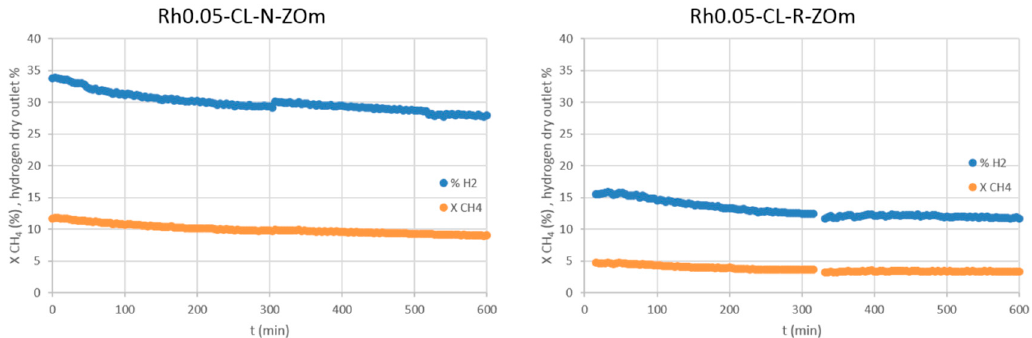
Figure 19. Methane conversion and hydrogen dry outlet percentage obtained on Rh0.05-CL-N-ZOm ( left ) and Rh0.05-CL-R-ZOm ( right ).